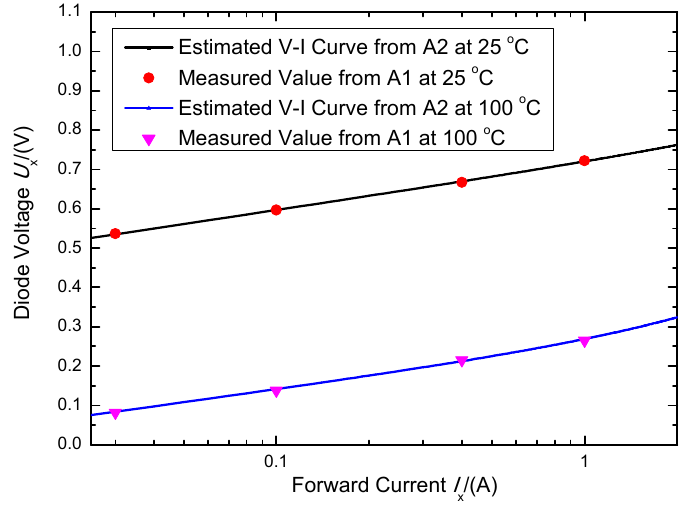
Figure 5. Diagram showing comparison between fitting curve and measured curve.